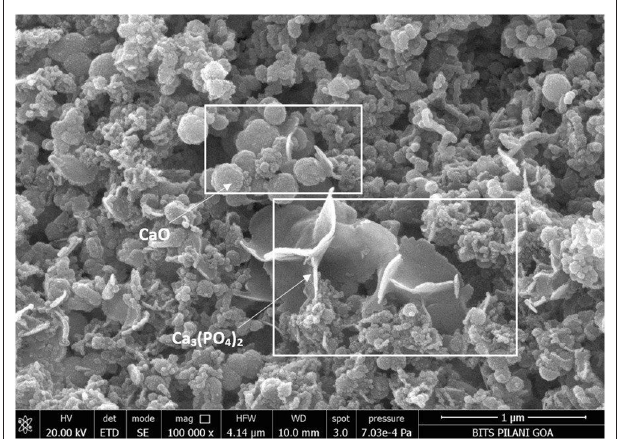
FIGURE 4 | SEM images of anodic precipitate at 100,000 × magnification showing circular button head like structures of calcium oxide and needle shaped calcium phosphates.